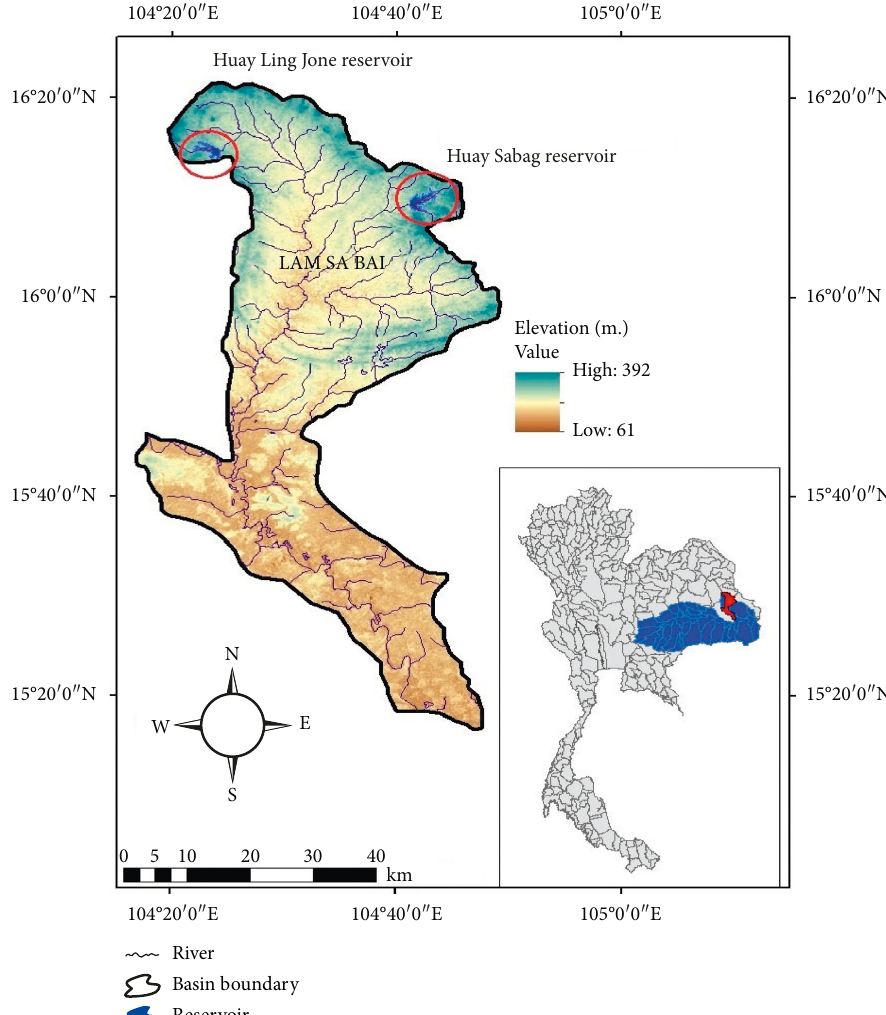
Figure 1: Map of the study